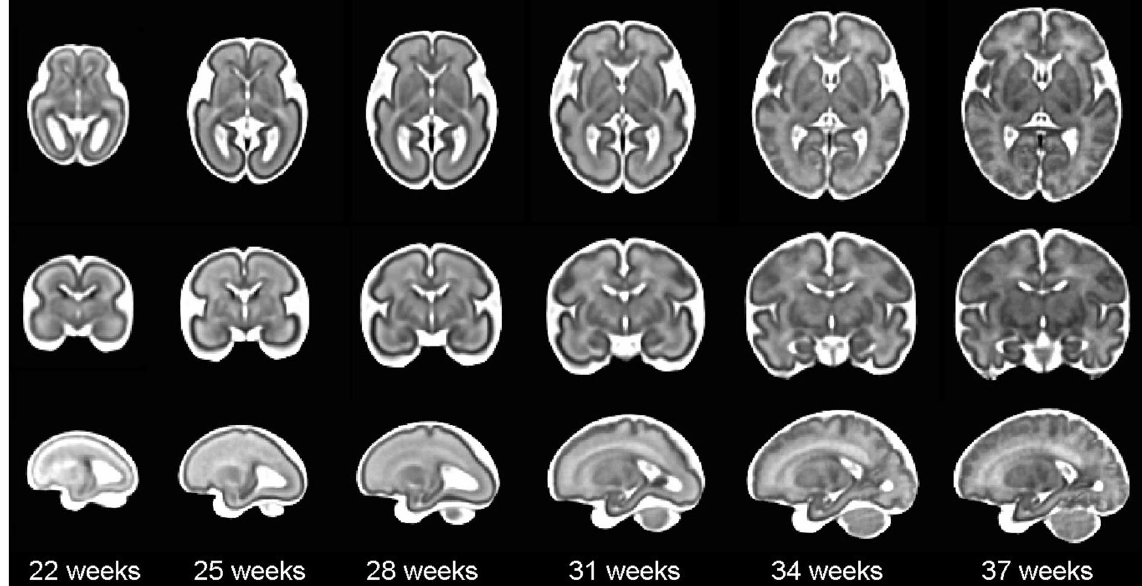
Figure 4. The spatiotemporal fetal brain MRI atlas (CRL fetal brain atlas) at six representative GAs: 22, 25, 28, 31, 34, and 37 weeks. Axial, coronal, and sagittal views of the atlas have been shown at each age point. Note that the spatiotemporal atlas construction process is a time-continuous process, therefore the atlas can be constructed at any continuous age point within the age range of the subjects used in the atlas construction